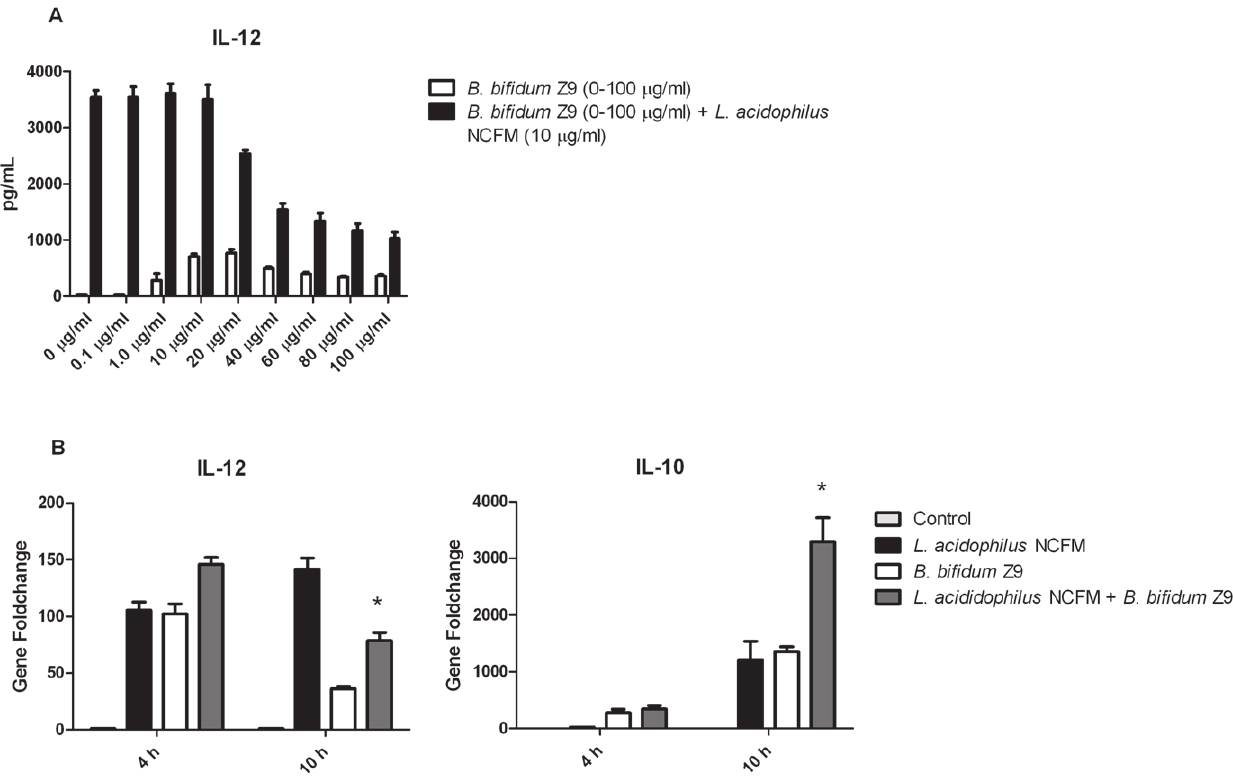
Figure 1. Inhibitory and additive effects of Bifidobacteriumbifidum Z9. A. The inhibitory effect of B. bifidum Z9 on the IL-12 production of L. acidophilus NCFM stimulated dendritic cells was determined by ELISA testing various concentrations of B. bifidum Z9 (0–100 m g/ml) against a constant concentration of L. acidophilus NCFM (10 m g/ml). B. B. bifidum Z9 exerts inhibitory effects on the expression of Il12 and additive effects on the expression of Il10 in L. acidophilus NCFM stimulated dendritic cells in a time dependent manner. Gene expression was measured by RT-PCR 4 h and 10 h after stimulation with the indicated bacteria ( L. acidophilus NCFM versus L. acidophilus NCFM + B. bifidum Z9 P , 0.01). Data show results from one out of five independent